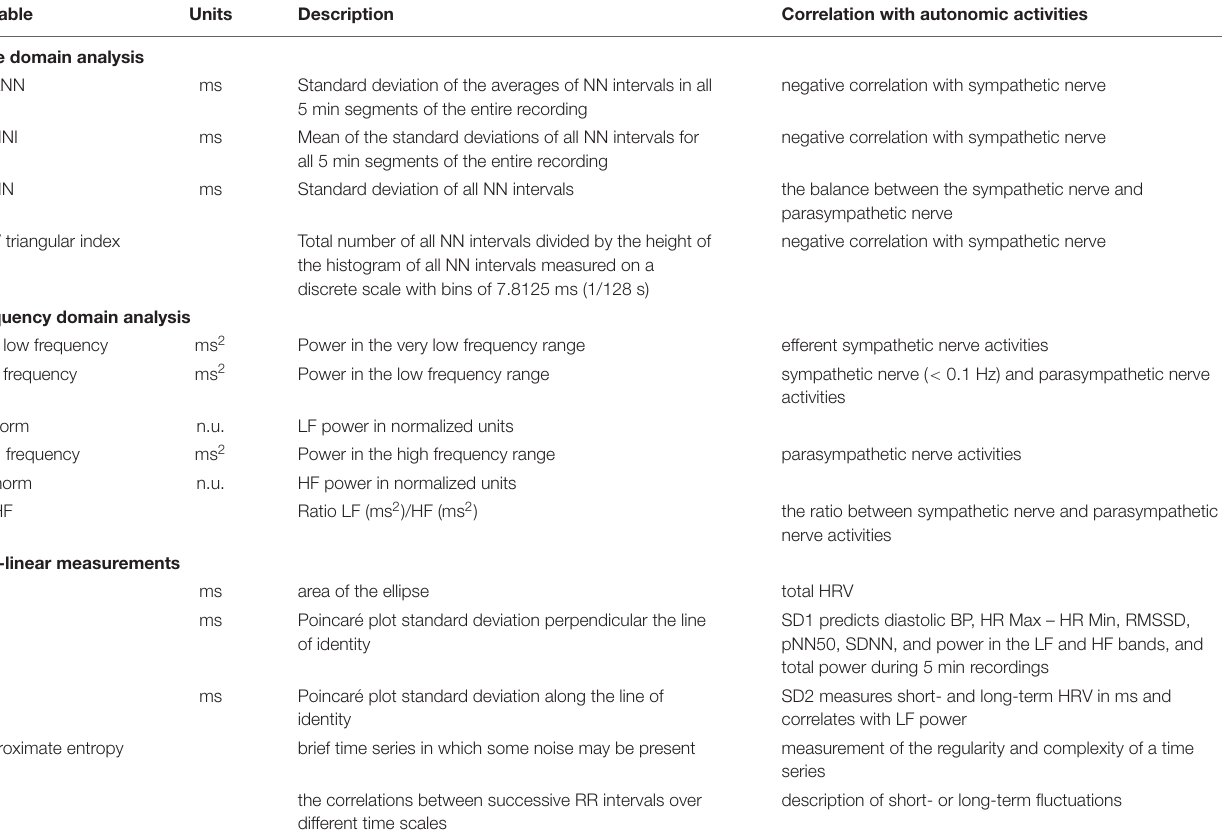
TABLE 1 | Overview of heart rate variability (HRV) analysis for sympathetic nerve activities.